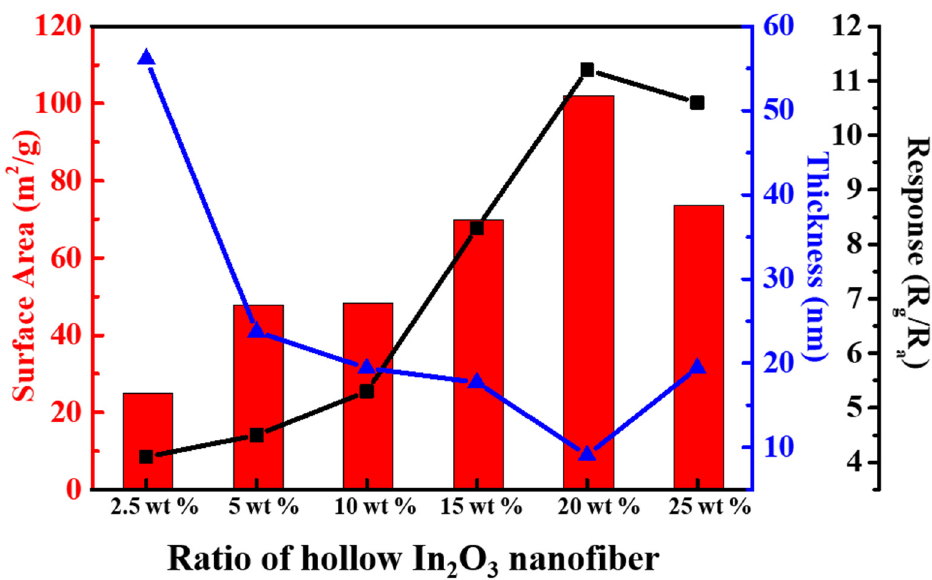
Figure 7. The surface area and thickness of PANI-coated hollow In 2 O 3 nanofiber and the response versus the loading of hollow In 2 O 3 nanofiber of PANI/hollow In 2 O 3 nanofiber composites. The PANI/N-GQD/hollow In 2 O 3 nanofiber sensor was applied to detect NH 3 in a concentration ranging from 0.6 ppm to 2.0 ppm at room temperature and to estimate the NH 3 -sensing performance of the composite sensor used in the analysis of human breath for hepatic or kidney disease. The NH 3 -sensing performance of the PANI/N-GQD/hollow In 2 O 3 nanofiber sensor compared with the PANI and PANI/hollow In 2 O 3 nanofiber sensors is shown in Figure 9a. These results indicate that the response of each sensor immediately increased as the exposure to NH 3 increased and then dropped significantly to an initial state after exposure to dry air. When the concentration of the analyte increased, the response of each sensor increased significantly. These results suggest that all responses of the three sensors had almost the same trend but the response values of the three sensors at the same concentration were exceptionally different. The response values of the PANI/N-GQD/hollow In 2 O 3 nanofiber sensors were about 9.4, 11.6, 15.2, 17.4, 22.7, 28.6, 35.8, and 41.2 toward to the corresponding concentrations of 0.6, 0.8, 1.0, 1.2, 1.4, 1.6, 1.8, and 2.0 ppm, respectively. It is apparent that the PANI/N-GQD/hollow In 2 O 3 nanofiber sensor exhibited the highest response among the three sensors. At 1.0 ppm, the response value of the PANI/N-GQD/hollow In 2 O 3 nanofiber sensor was about 4.4 and 1.4 times higher than those of the PANI and PANI/hollow In 2 O 3 nanofiber sensors, respectively. Figure 10 shows the responses of the three sensors as a function of various concentrations of NH 3 . These curves reveal that the correlation between the response values and the NH 3 concentration is nearly linear. The corresponding functions were determined as y = 2.04x + 2.55, y = 15.23x − 3.88, and y = 23.95x − 10.41 for the PANI, PANI/hollow In 2 O 3 nanofiber, and PANI/N-GQD/hollow In 2 O 3 nanofiber sensors, respectively. The correlation coefficients, R 2 , were approximately equal to 0.994. The slopes of the corresponding lines, designated as the sensitivities of the sensors, reveal that the sensitivity of the PANI/N-GQD/hollow In 2 O 3 nanofiber sensor was superior to those of the PANI and PANI/hollow In 2 O 3 nanofiber sensors. These findings suggest that the PANI/N-GQD/hollow In 2 O 3 nanofiber sensor has a greater ability to detect NH 3 , recommending it for suitable use as a favored substance for NH 3 gas detection. A comparison of the sensing performance of the PANI/N-GQD/hollow In 2 O 3 nanofiber sensor and previously described devices was recorded in Table 2. It is evident that the